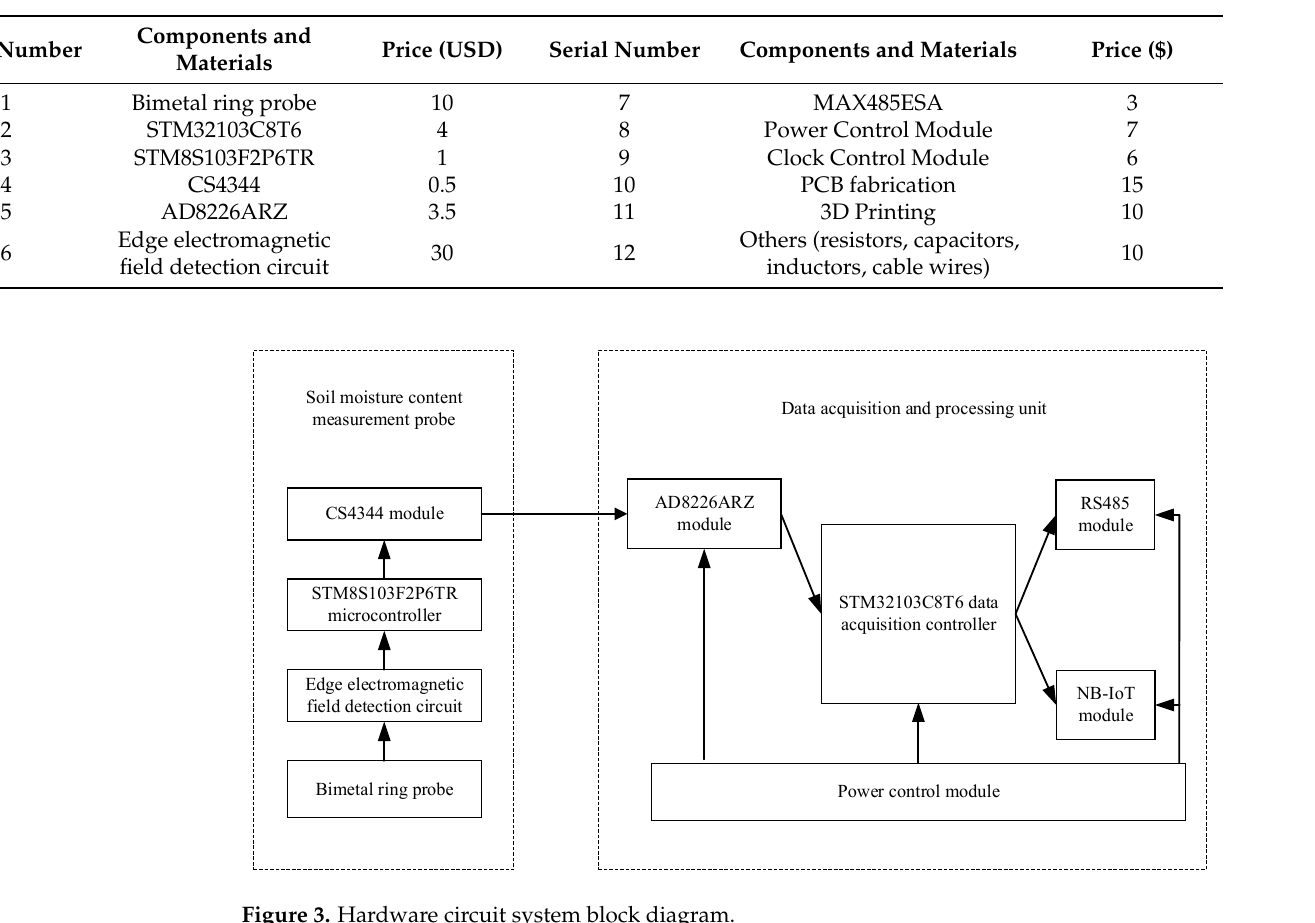
Table 1. Price breakdown of components and materials for the EEMFI sensor.